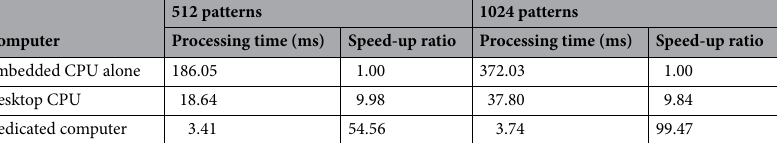
Table 1. Reconstruction times of each computer, and speed-up ratio relative to the embedded CPU